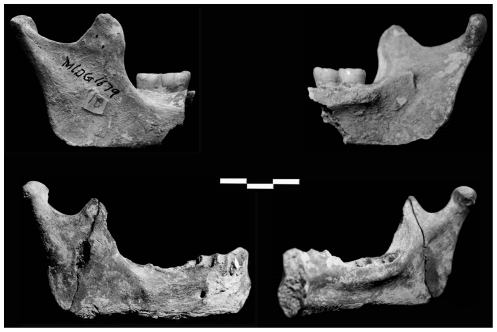
Maludong mandibles MLDG 1679 (left) and MLDG 1706 (right) (scale bar = 1 cm).NB: MLDG 1706 is broken through its symphysis just lateral to the MSP.